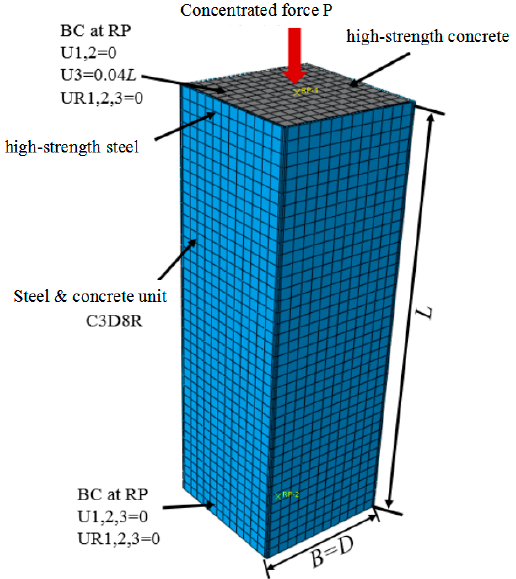
Figure 3. Mesh size selection and schematic view of the FE model.